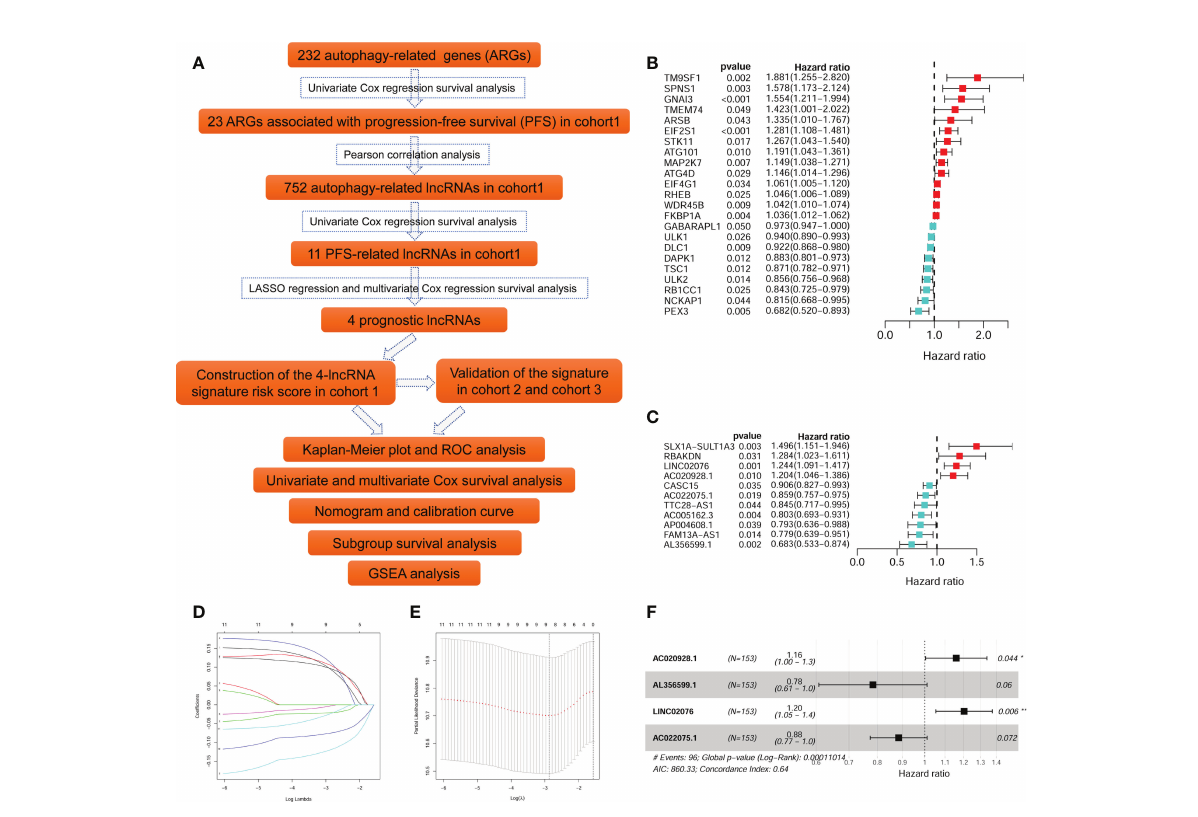
FIGURE 1 Identi fi cation of autophagy-related lncRNAs associated with PFS. (A) The fl owchart of this study. (B) The univariate survival analysis of the 23 ARGs associated with PFS of NB patients in cohort 1. (C) The univariate survival analysis of the 11 autophagy-related lncRNAs associated with PFS of NB patients in cohort 1. (D, E) The LASSO regression analysis. (F) The multivariate survival analysis of the four lncRNAs with the best prognostic value for PFS. ARG, autophagy-related gene; PFS, progression-free survival; lncRNA, long noncoding RNA; NB, neuroblastoma; LASSO, least absolute shrinkage and selection operator. * p < 0.05 and ** p <